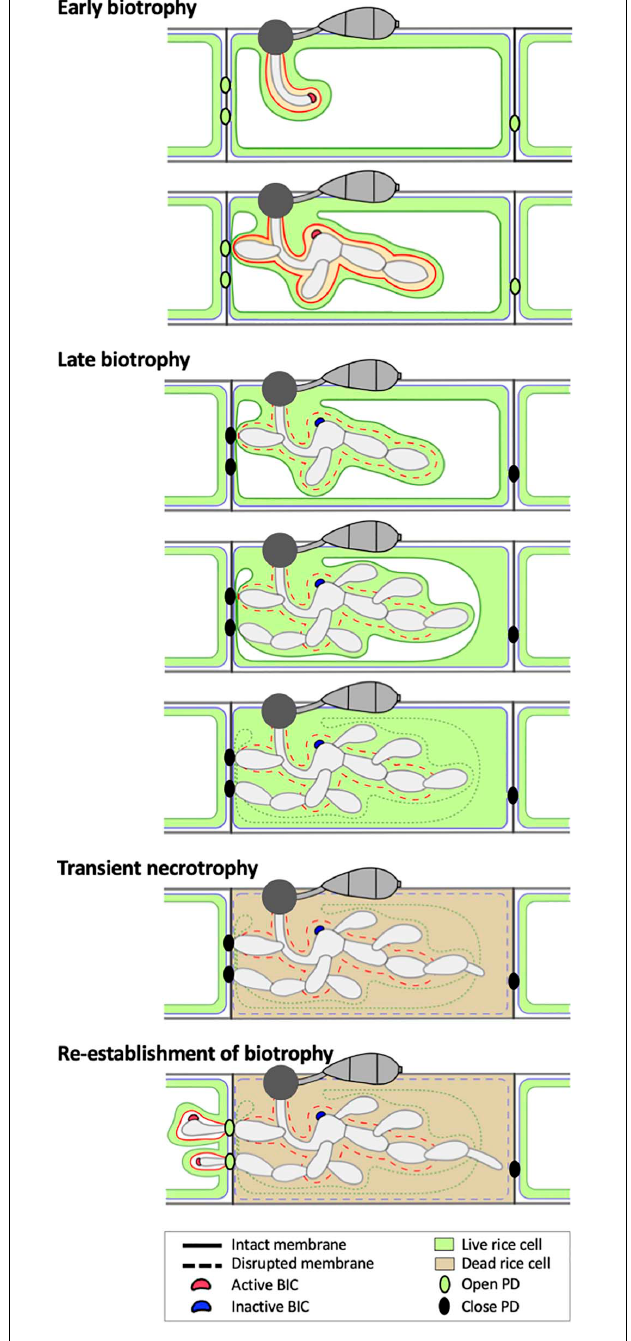
FIGURE 8 | Model of the hemibiotrophic lifestyle of M. oryzae during invasion of the first and second rice cells. Early Biotrophy: An initial invasion of a rice cell is achieved by a filamentous primary hypha, which differentiates into the first bulbous IH cell. The tip BIC positioned at the apex of the primary hypha is left at a subapical position when the first bulbous cell differentiates. Branched bulbous IH then arise from both the first bulbous cell and from the primary hypha. All IH are encased by an intact EIHM. The EIHM-encased IH also invaginate the vacuole, resulting in a thin layer of cytoplasm on the rice-facing side of the EIHM. Apoplastic effectors are retained within the EIHMx, while